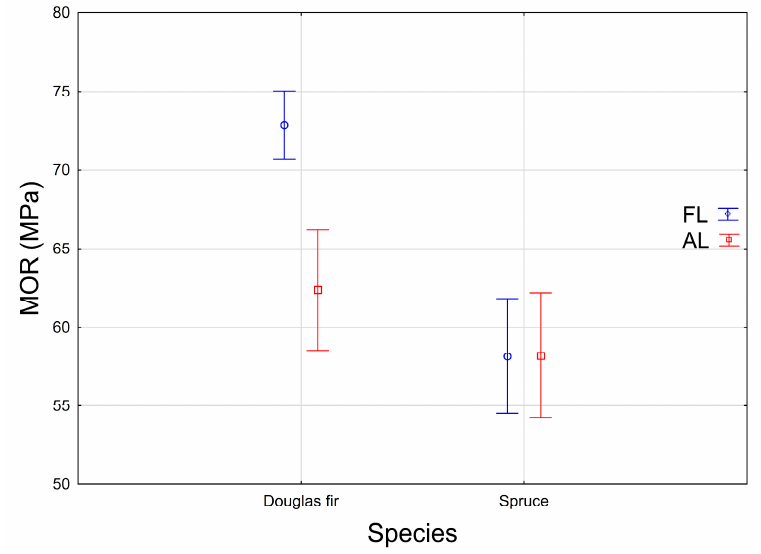
Figure 3. Impact of site on modulus of rupture.